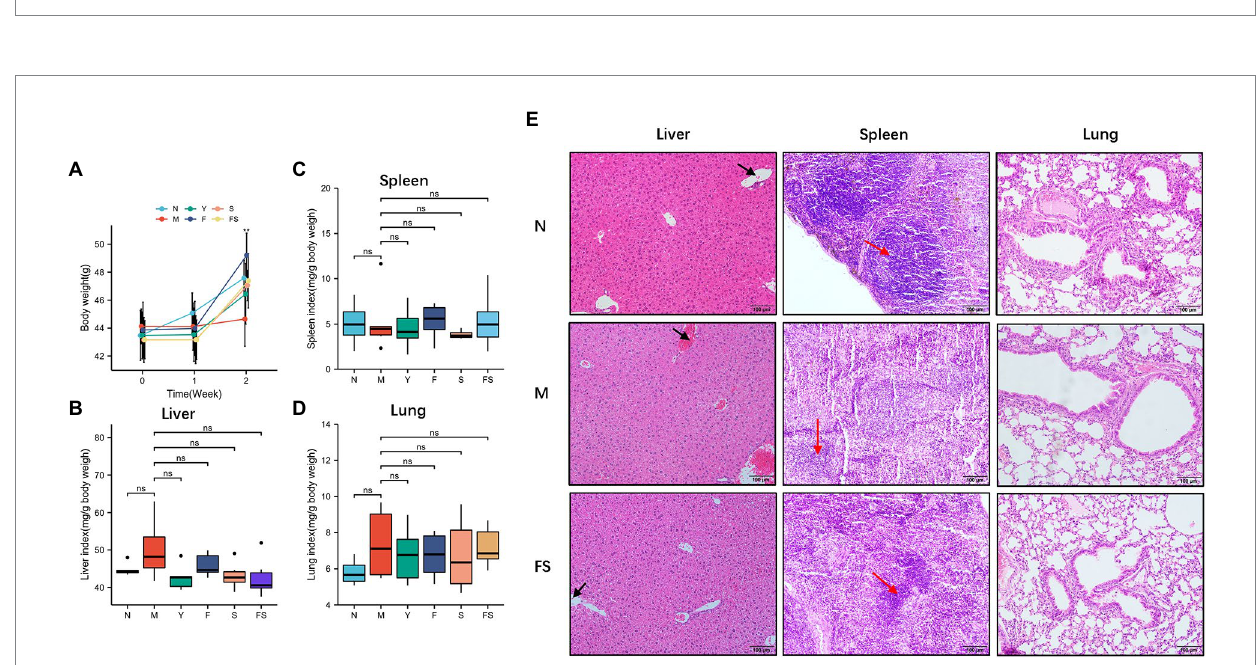
FIGURE 5 Postbiotic of hawthorn-Probiotic are safe and promote blood circulation and spleen immune cell growth. (A) Mice’s body weight after modeling and administration; (B) liver organ index of mice after administration; (C) spleen organ index of mice after administration; (D) lung organ index of mice after administration; (E) hematoxylin and eosin (H&E) staining in mice’s livers, spleens and lungs tissue. NS; * p < 0.05; ** p < 0.01; *** p < 0.001.